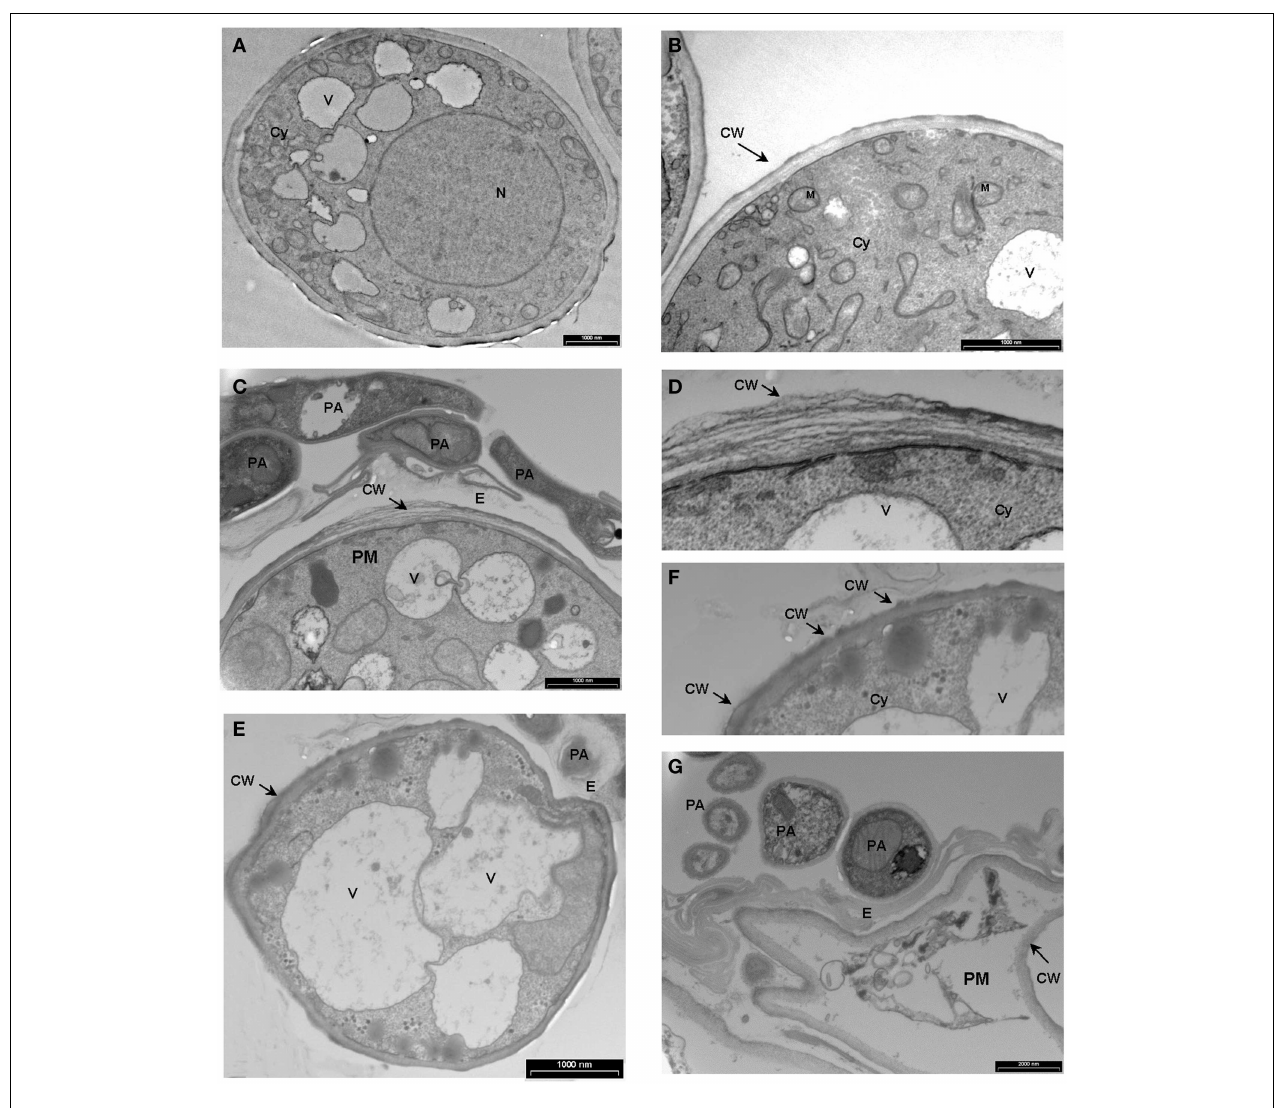
interactions on cucumber leaves 8 days post-inoculation and 11 days post-treatment with P. aphidis . (C) P. aphidis cells encircle the P. xanthii hyphae causing deformation of the cell wall (CW), also seen at higher magnification in (D) . (E) Increased vacuolation is accompanied by deformation of the cell wall and disorganization of the cytoplasm, also seen at higher magnification in (F) . (G) P. xanthii cells are markedly collapsed. E, extracellular